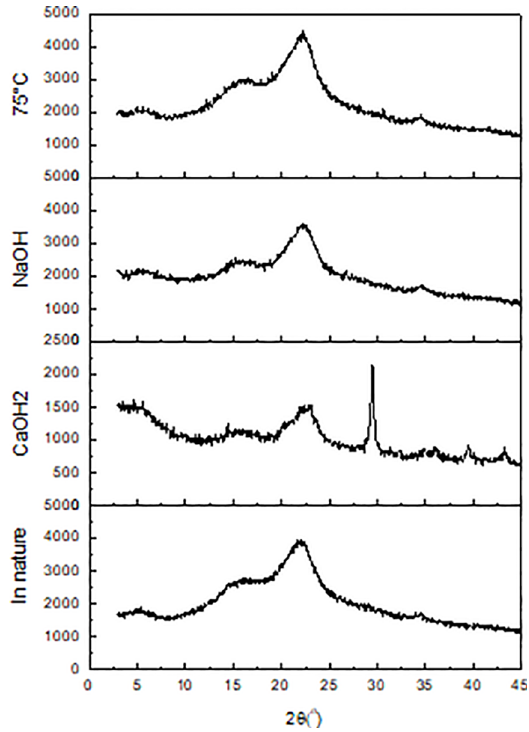
Figure 6. XRD diffractograms of piassava fibers: "In natura", treated with Ca(OH) , NaOH and with hot water at 2